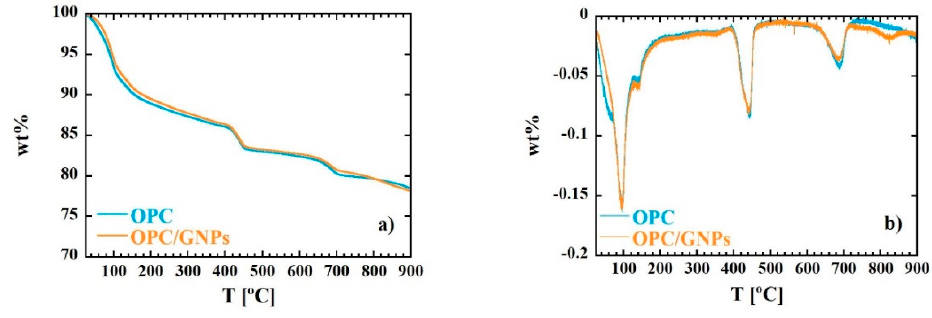
Figure 1. Thermal Gravimetric (TG) ( a ) and Differential Thermal Gravimetric (DTG) ( b ) curves for OPC and OPC/GNPs samples.